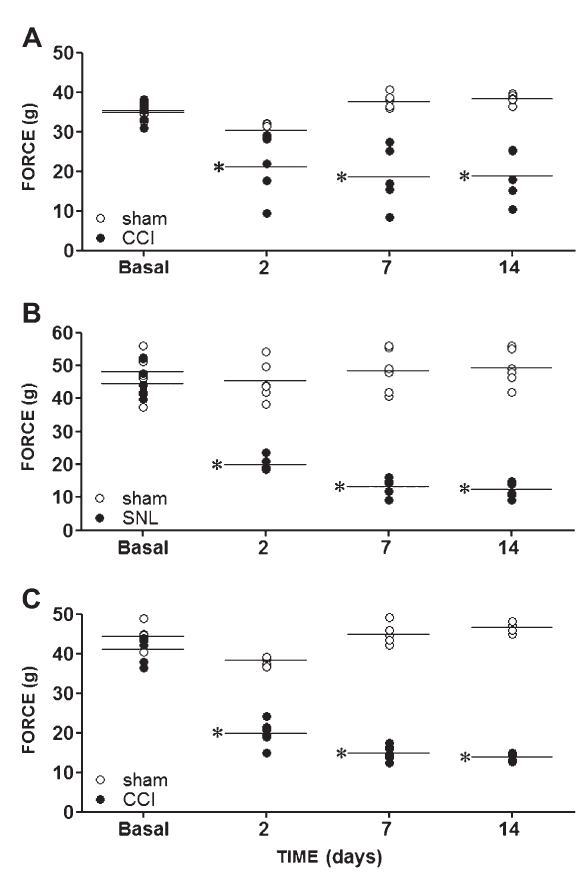
Figure 1. Time-course of hyperalgesia measured with an automated electronic von Frey apparatus. The changes in the reflex threshold of each rat are shown before surgery (basal) and 2, 7, and 14 days after chronic constriction injury (CCI) of the sciatic nerve using the Bennett and Xie model ( A ), sciatic nerve ligation (SNL) using the Kim and Chung model ( B ), or a modified CCI model ( C ). The horizontal bars indicate the mean threshold for each group of rats (n = 5-6). *P , 0.05 compared to sham rats (MANOVA followed by the Bonferroni post hoc